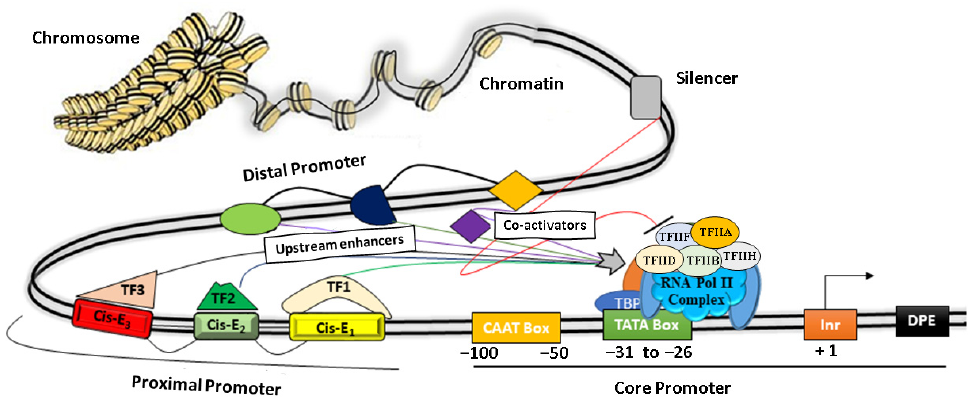
Figure 1. The basic architecture of plant promoters. The core promoter consists of a CAAT box, TATA box, Initiator element (Inr), and a downstream promoter element (DPE). Protein factors (TF IIA, IIB, IID, IIH, IIE, IIF, etc.) near the TATA box facilitate the binding of RNA Pol II to initiate transcription. The proximal regions (~1000 bp) and the distal promoter regulate the promoter activity by recruiting transcription factors (TF) on discrete Cis- elements ( Cis -E).